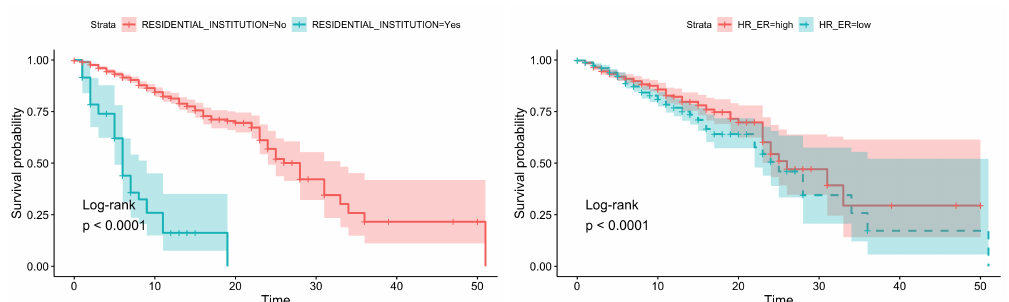
Figure 2. Survival analysis: ( Left ) Age. ( Right ) O 2 saturation.